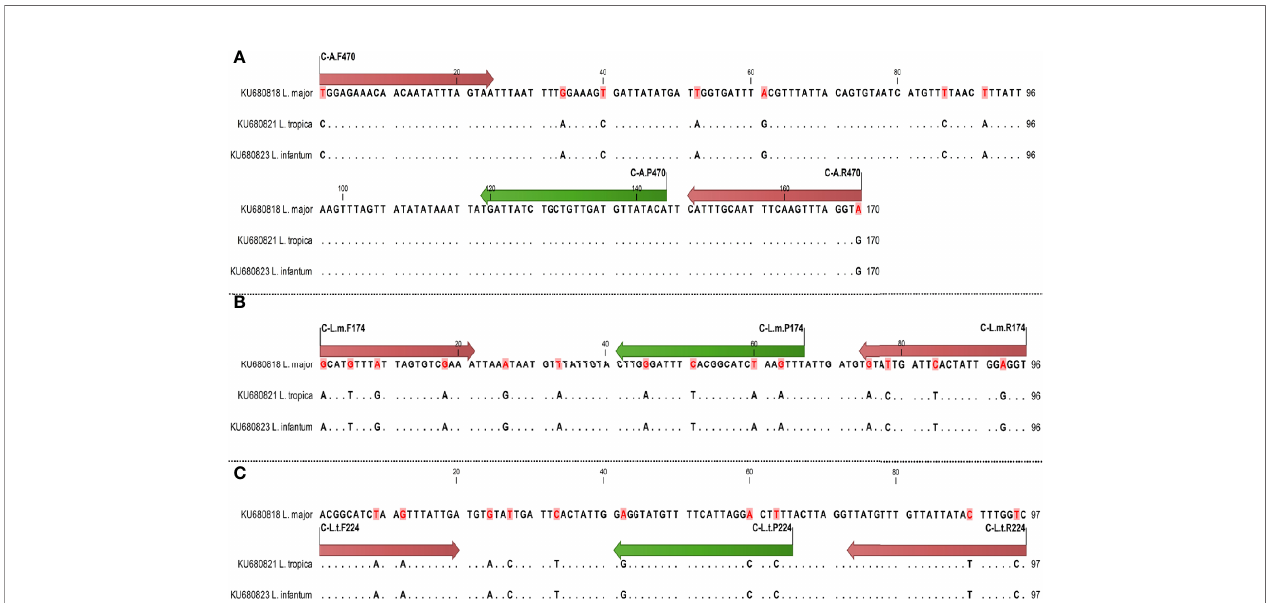
FIGURE 1 | Schematic illustration of primers and probes (nucleotide site variation) in COII gene for diagnostics of Leishmania species using qPCR, arrows of start and end sites showing primer sites and internal arrows showing probe sites; difference of nucleotides is speci fi ed by dot. The primer and probe sites are shown by red and green arrows, respectively. Sequences are speci fi ed by dot except different nucleotides. (A) Speci fi c primers and probes of all species; (B) speci fi c primers and probes of L. major ; (C) speci fi c primers and probes of L. tropica